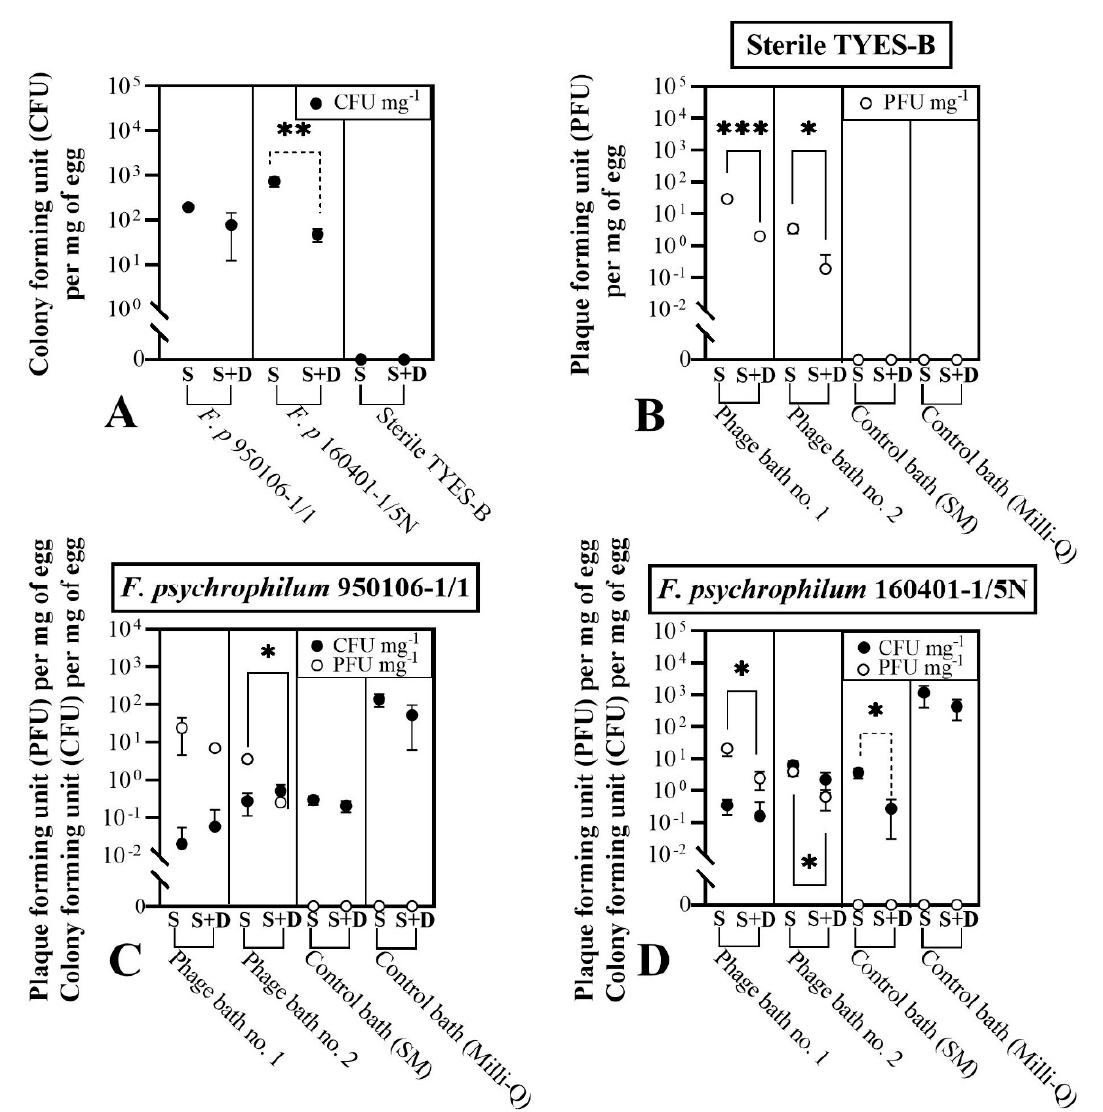
Figure 5. Exp. I, section C: effects of the drying procedure on bacterial and phage concentrations in connection with eyed eggs. Comparison between standard sampling (indicated by “S”) and sampling with the additional drying step (indicated by “S + D”) for eyed eggs sampled at 0 hpi ( A, right after the bath challenge) and at 24 hpi ( B – D ) that were previously bath-challenged with TYES-B (control, B ), F. psychrophilum 950106-1/1 ( C ) and F. psychrophilum 160401-1/5N ( D ). Values represent the mean and standard deviation of three biological replicates. Unpaired t tests of log-transformed values were performed. Statistically significant comparisons (solid lines for phage concentrations and broken lines for bacteria concentrations) are visualized as follows: p < 0.05 (*), p < 0.001 (**), p < 0.0001 (***). Phage bath no. 1: 10 9 PFU mL − 1 ; phage bath no. 2: 10 8 PFU mL − 1 .